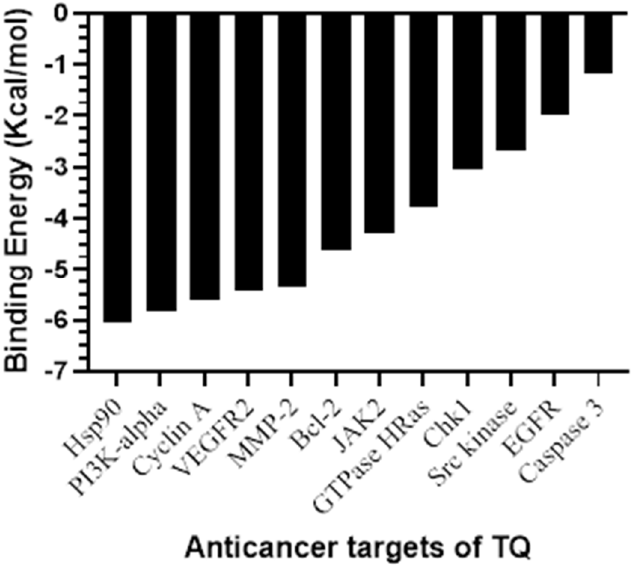
Figure 1. A bar plot of molecular docking–predicted binding energy (in kcal/mol) of TQ against potential anticancer drug targets.